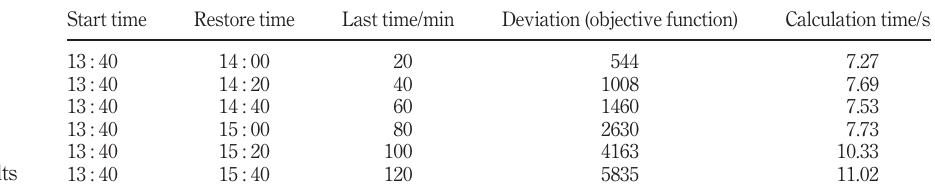
Table 4. Scenario 1 results